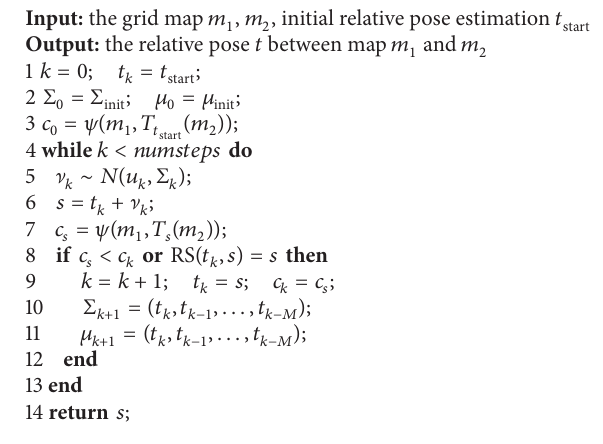
Algorithm 3: Random walk